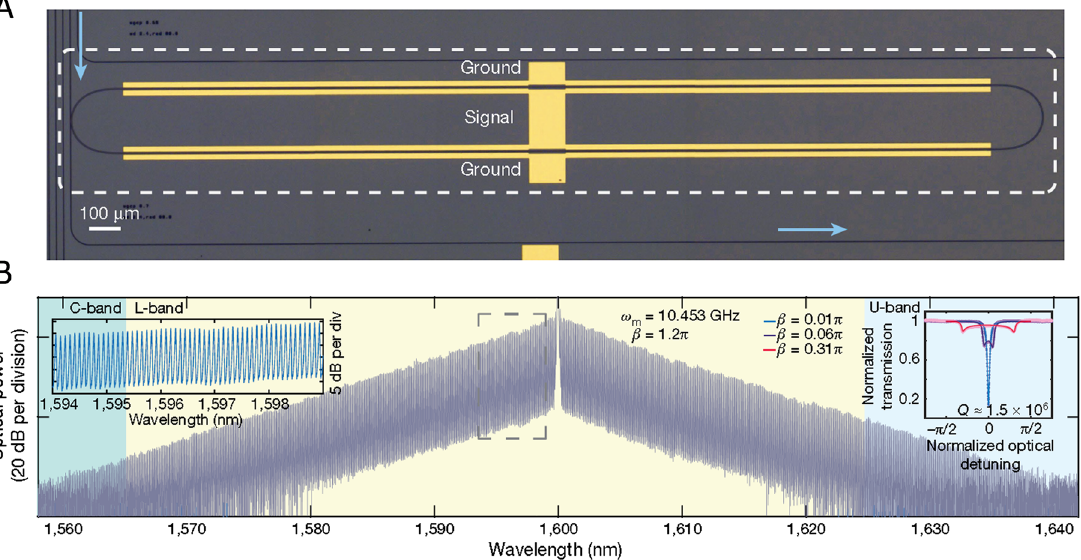
Figure 12: (A) Micrograph of an integrated lithium niobate microring resonator EO comb generator. (B) Measured optical spectrum of the EO frequency comb generated from the integrated lithium niobate microring resonator, with a bandwidth exceeding 80 nm and more than 900 comb lines with a slope of 1 dB nm − 1 . (Left inset) A magni fi ed view of comb lines with a line-to-line power variation of ∼ 0.1 dB (Right inset) Measured transmission spectrum for different modulation indices. Reprinted with the permission from Ref. [112], Copyright 2019, Springer